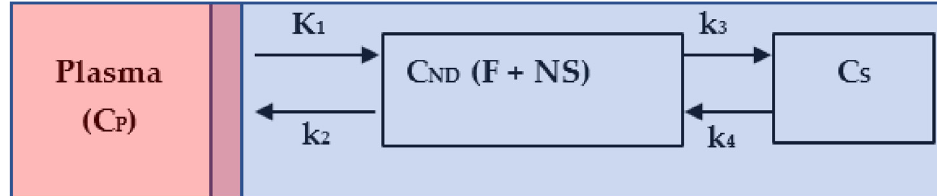
Figure 1. Two-tissue compartment model. The red area represents the total plasma, the mixed area represents the input to the tissue derived from the plasma, and the blue area represents the tissue: non-displaceable, that is, free plus nonspecific (F + NS), and the specific